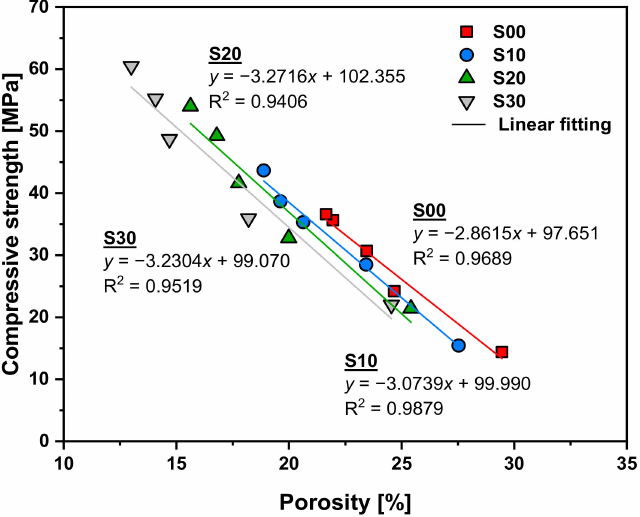
Figure 8. Compressive strength as a function of porosity.